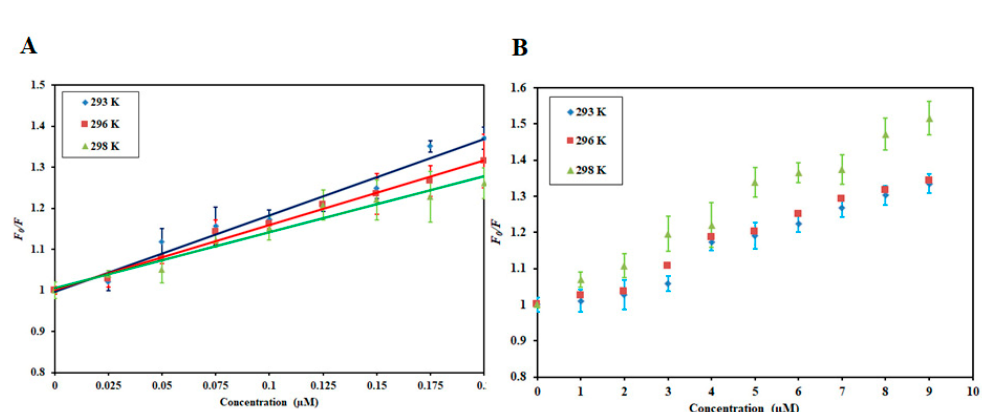
Figure 2. Stern − Volmer plots of ( A ) MARK4 − DP and ( B ) MARK4 − RT at three di ff erent temperatures. The temperatures used in the study were 293 K, 296 K, and 298 K.